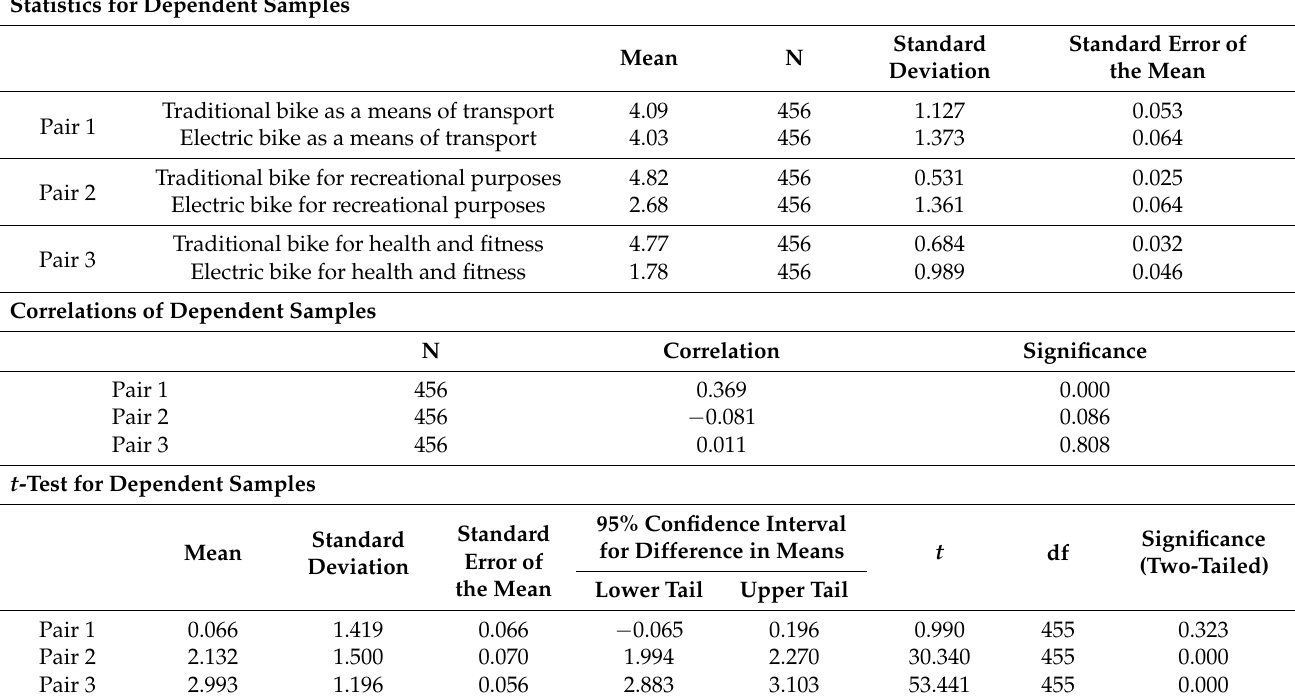
Table A1. Results of the t -test for dependent samples for the question: “What do you think a traditional bicycle and an electric bicycle are used for? (1—least, 5—most)”. Statistics for Dependent